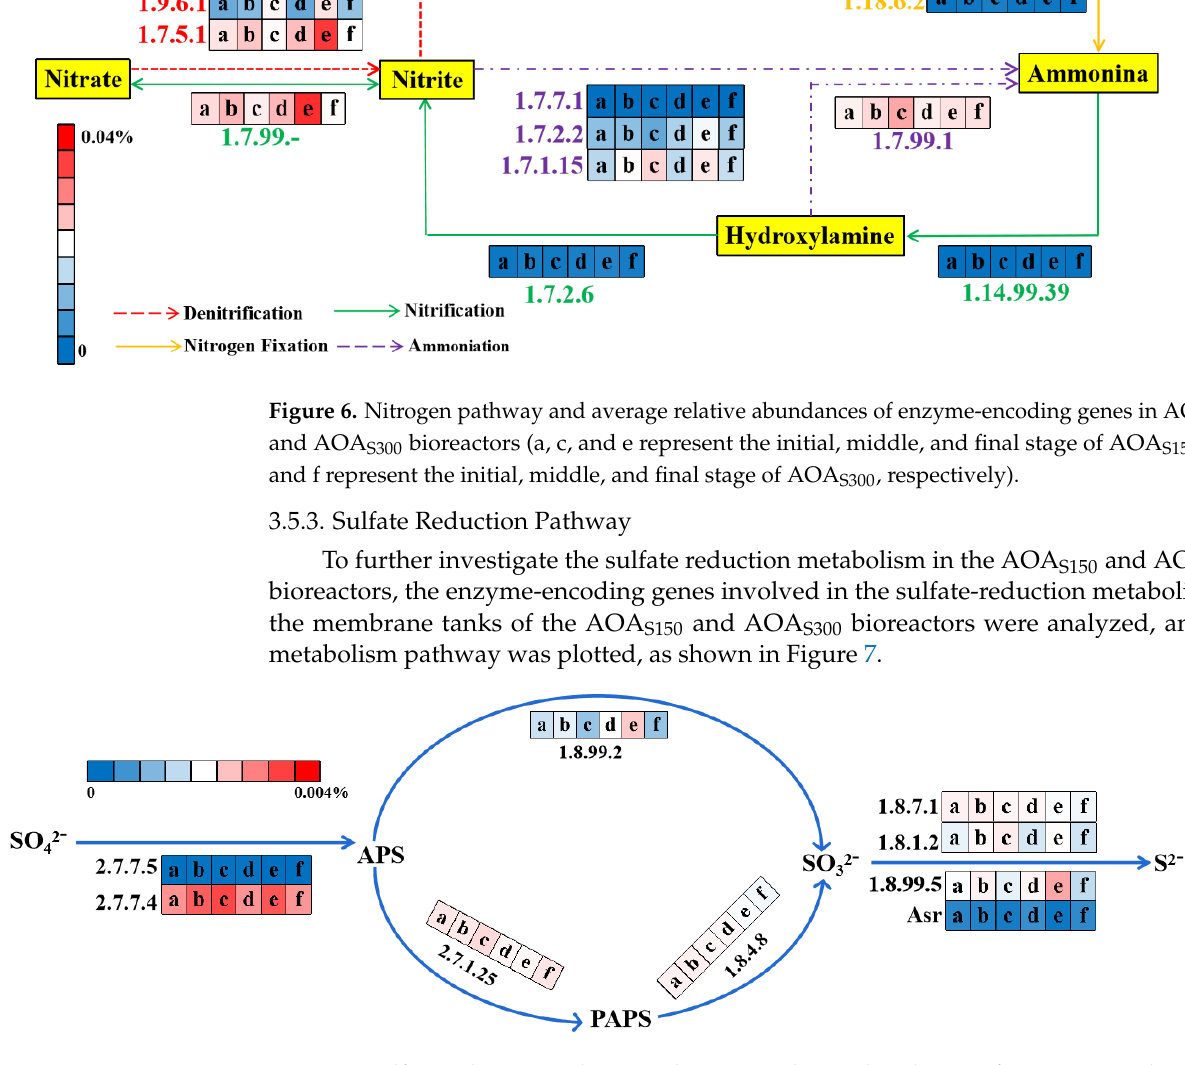
Figure 7. Sulfate reduction pathway and average relative abundances of enzyme-encoding genes in AOA S150 and AOA S300 bioreactors (a, c, and e represent the initial, middle, and final stage of AOA S150 ; b, d, and f represent the initial, middle, and final stage of AOA S300 , respectively). Sulfate can be transformed to sulfide through assimilation and dissimilation reduc- tion [75]. There are four steps in assimilatory sulfate reduction: sulfate → adenosine phosphosulfate (APS) → 3 ′ -phosphoadenylyl sulfate (PAPS) → sulfite → sulfide. The fite → sulfide [76]. The total relative abundances of enzyme-encoding genes involved in sulfate reduction in the AOA S150 bioreactor were 0.047% (day 1), 0.059% (day 45),